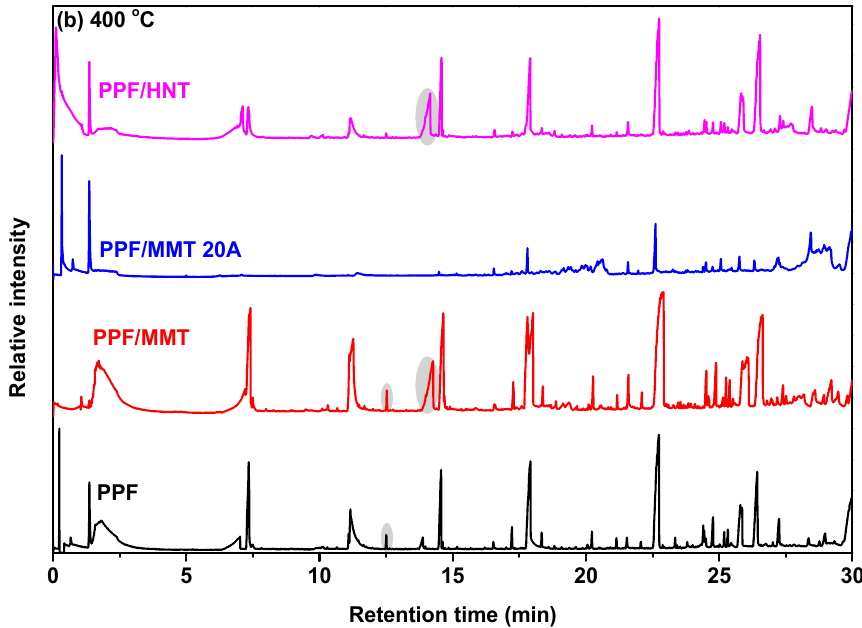
Figure 11. Gas chromatographs of PPF and its nanocomposites after pyrolysis at ( a ) 360 °C and ( b ) 400 °C.